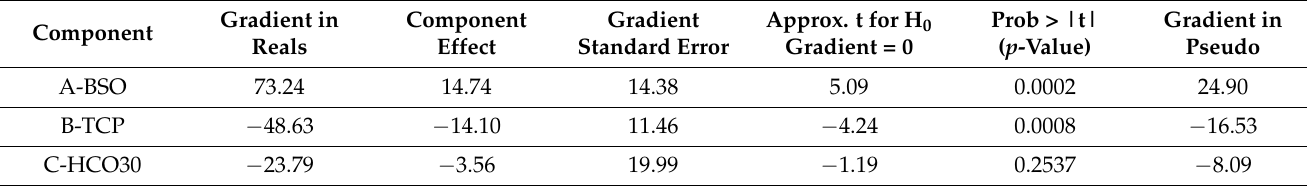
Table 4. Formulation components’ effects (Peipel) on droplet size.